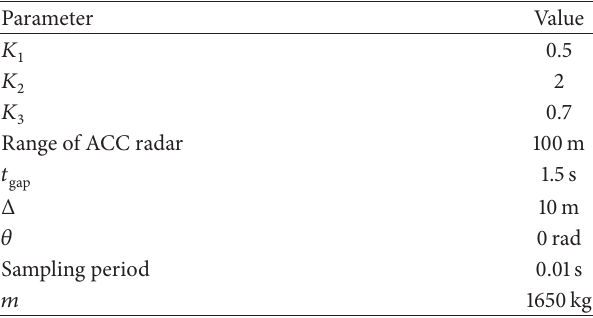
Table 2: Parameters for the ACC